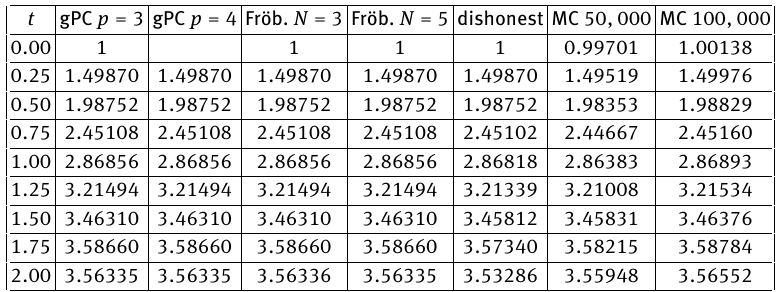
Table 1: Approximation of E [ X ( t )] . Example 4.1, assuming independent random data.